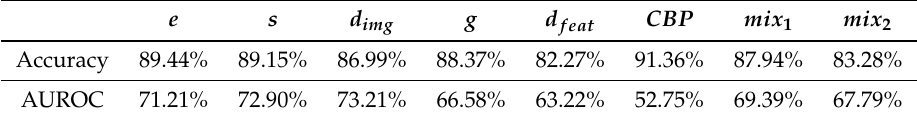
Table 5. Accuracy and AUROC of the uncertainty prediction on the MNIST test set.